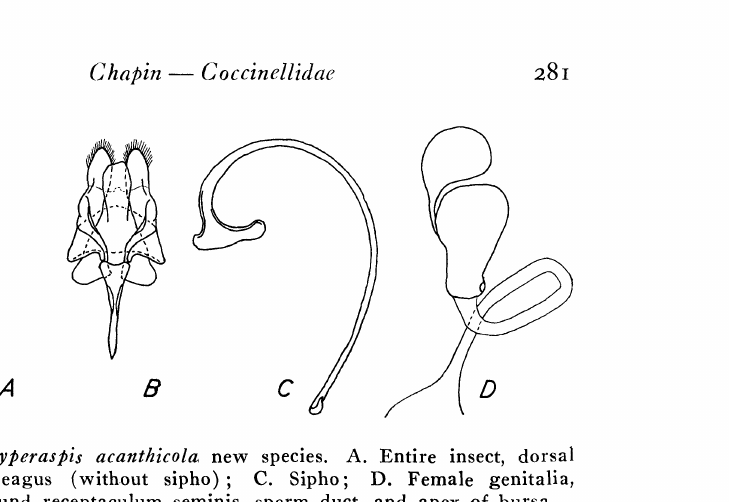
Figure 2. Hyperaspis acanthicola new species. A. Entire insect, dorsal view; B. Aedeagus (without sipho); C. Sipho; D. Female genitalia, showing compound reeeptaeulum seminis, sperm duet, and apex of